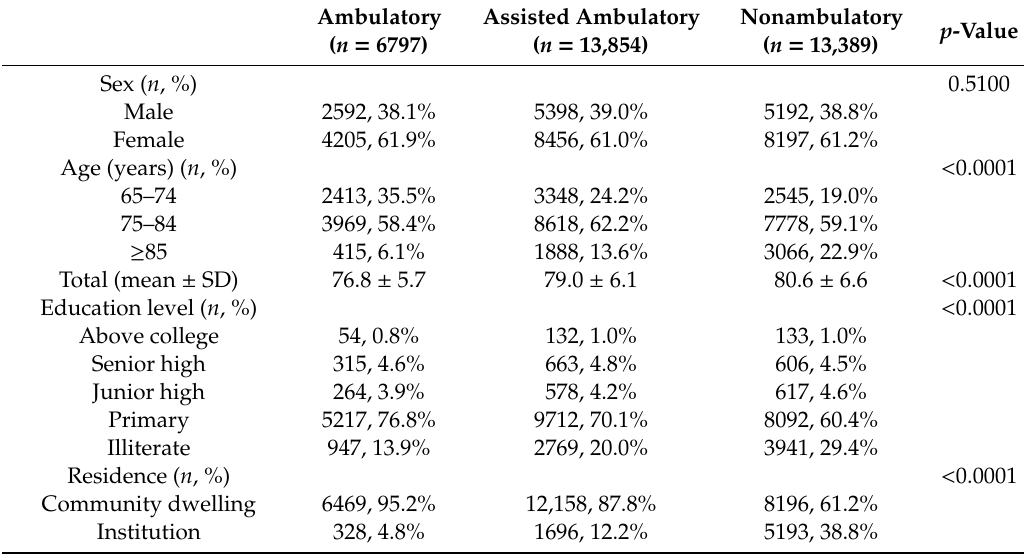
Table 1. Demographic data of all study